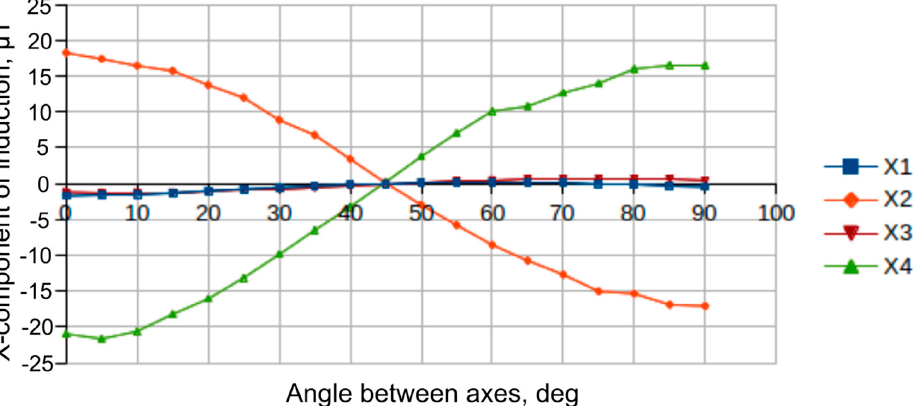
Figure 3. Dependence of the magnetic induction vector component along the X-axis in the cores of ferromagnetic probes ("X1"–"X4" curves correspond to "D1" − "D4" elements).